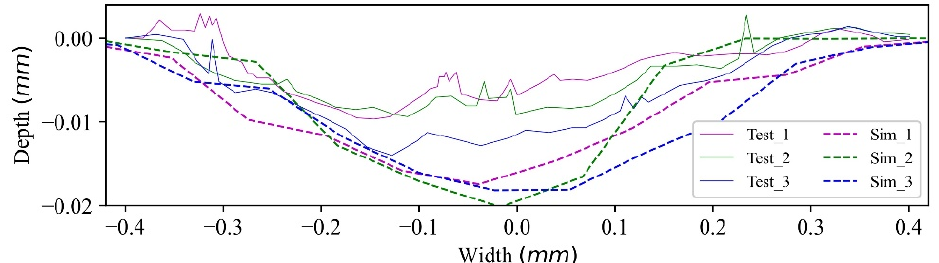
Figure 17. Wear profile.